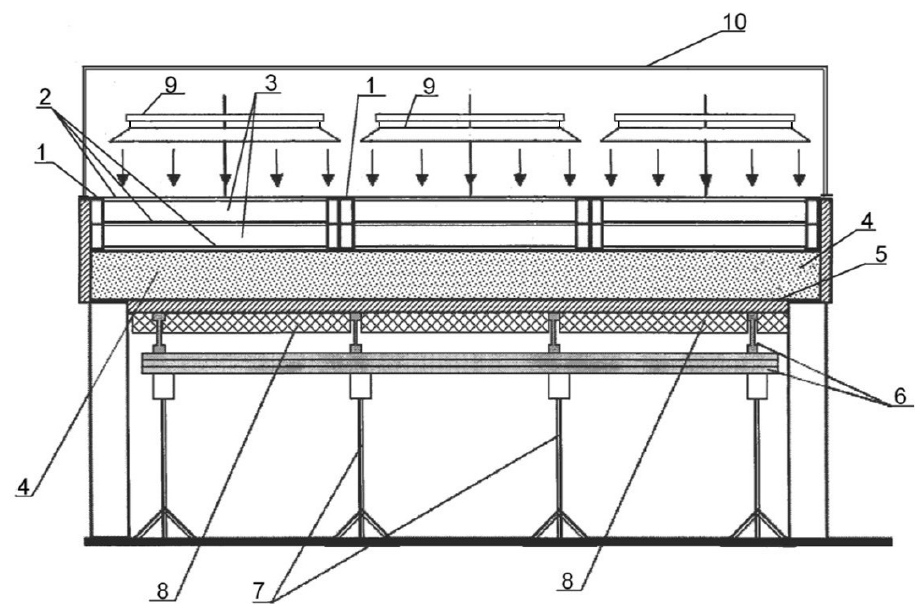
Figure 1. Layout of HT of a slab with BF-reinforced ECC using infrared rays for cast-in-situ construction in frosty weather: 1—clamps for fixing polyethylene-terephthalate membranes; 2— polyethylene-terephthalate membranes; 3—airbags (gaps); 4—concrete mix; 5—deck panels; 6— support beams; 7—telescopic stands; 8—heat insulation; 9—infrared appliance;